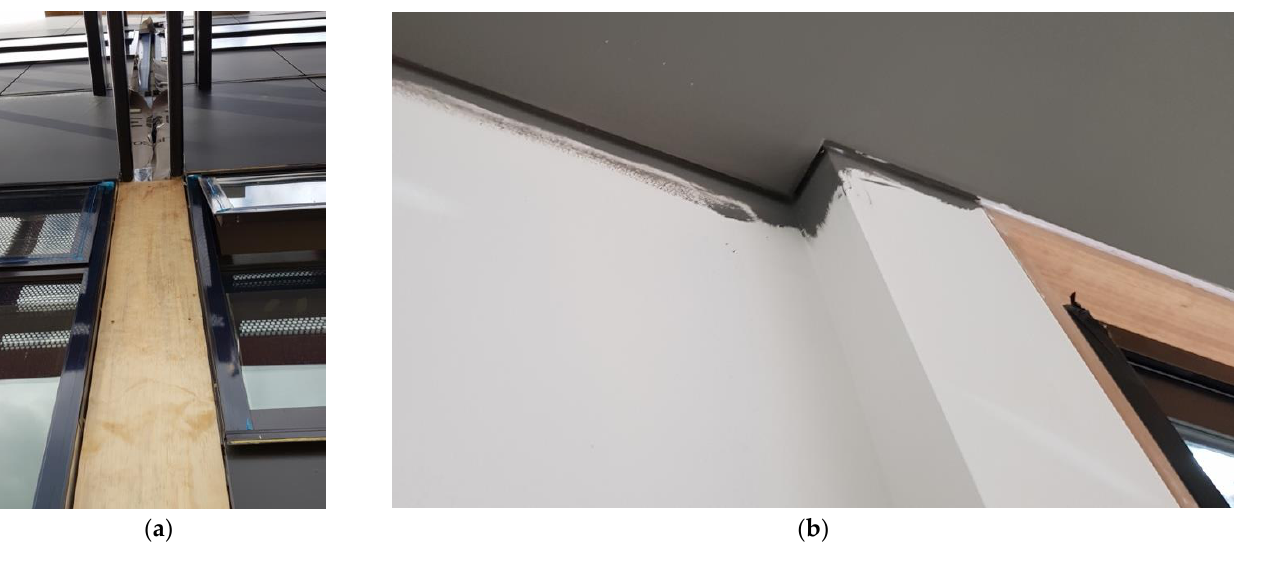
Figure 15. Detailing of Finishes: ( a ) External finishes—A module split detailed so that a certain strip of the facade can be installed on site, allowing more work to be completed offsite; ( b ) Internal finishes—A gap left between the plasterboards of a ceiling and a partition wall (usually covered by a cornice) to act as a movement joint during transportation.